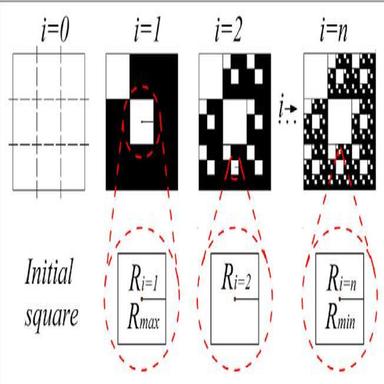
Sierpinski carpet. The geometrical construction starts from a square divided in 9 sub-squares. At each iteration i, 2 squares are removed generating the void microstructure. For i = 1 voids have ray Rmax (the characteristic size). Iteration by iteration, pore structure grows until the last iteration in which pores have ray Rmin. In the figure the fractal dimension is Df = = log(7)/log(3) 1.771.